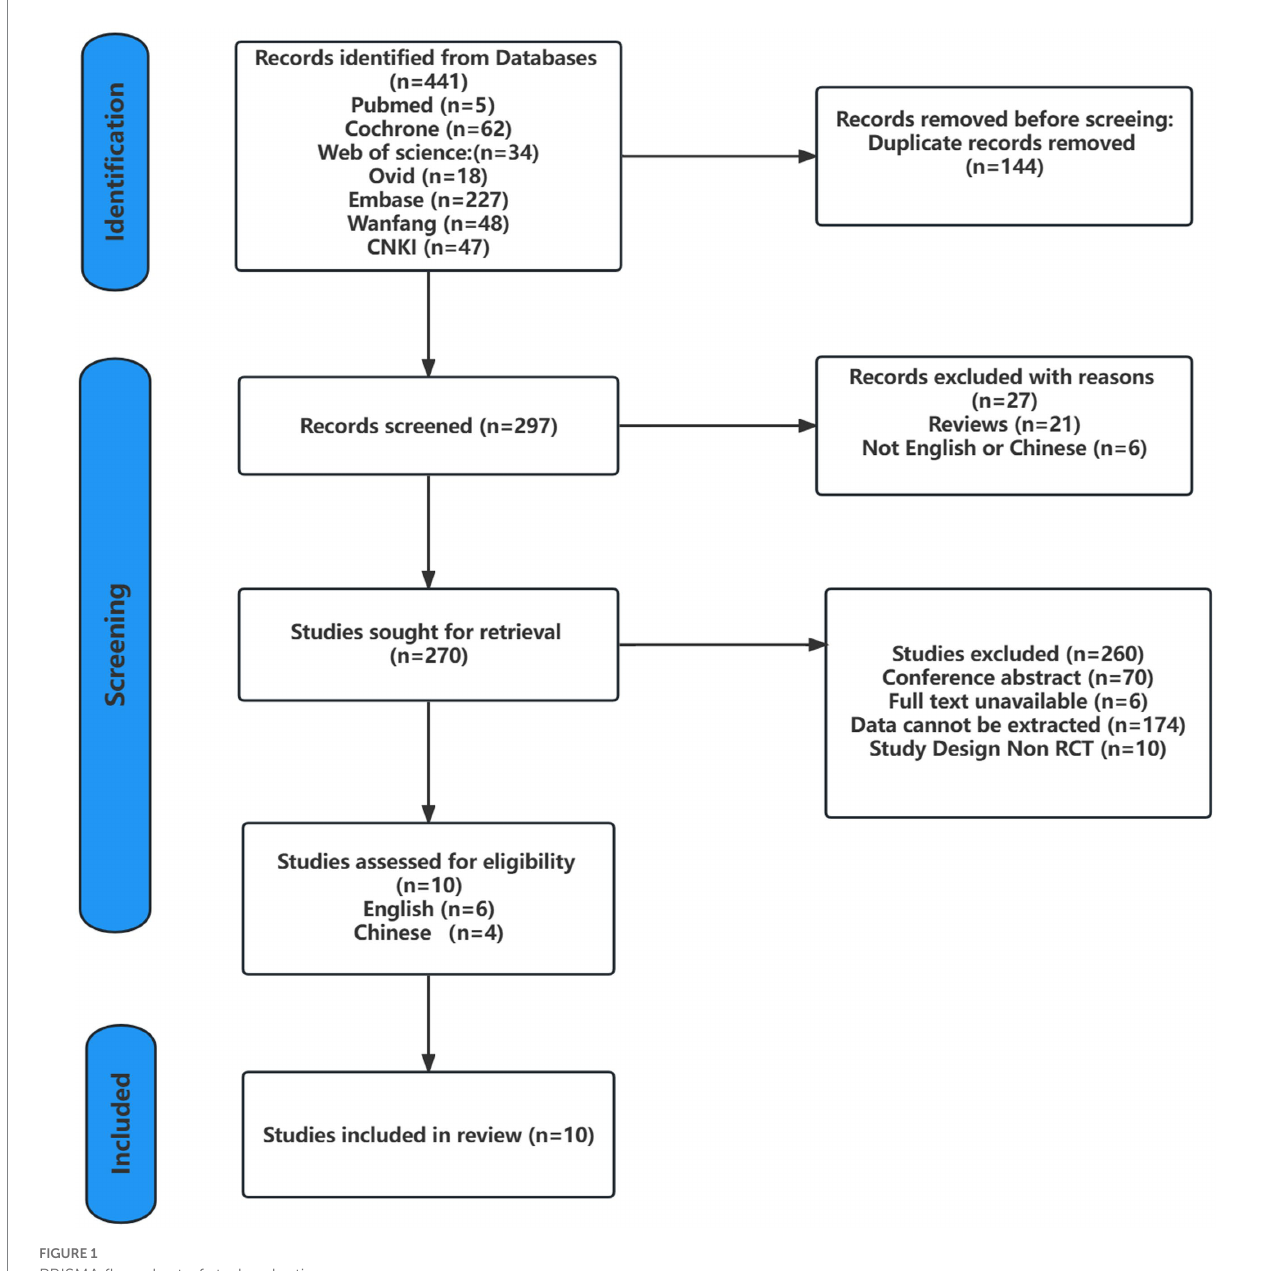
FIGURE 1 PRISMA flow chart of study